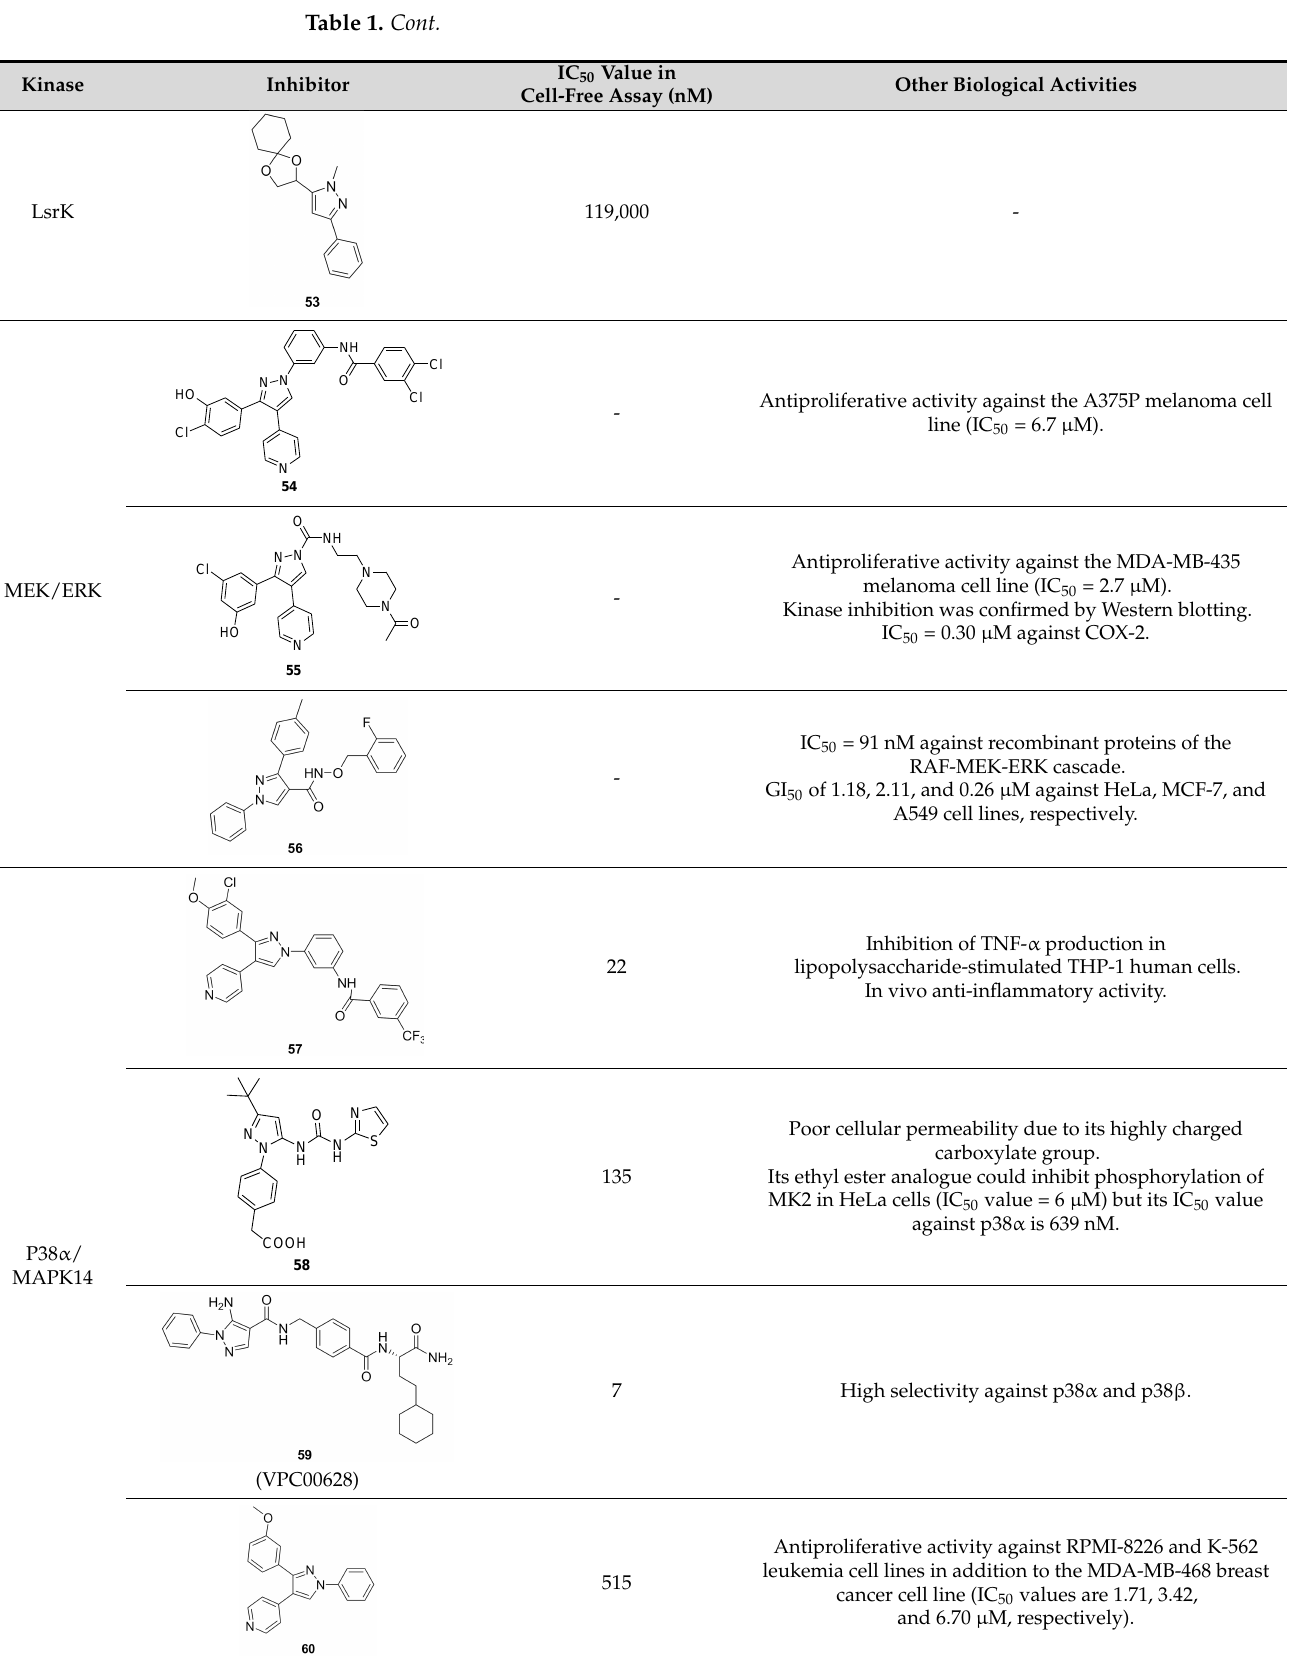
Antiproliferative activity against the A375P melanoma cell line (IC 50 = 6.7 µM).